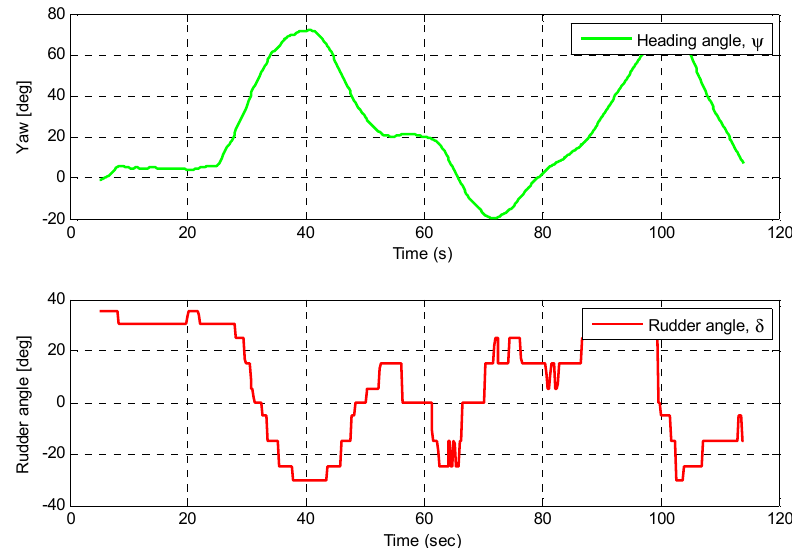
Figure 18. Heading angle and rudder angle during the test.